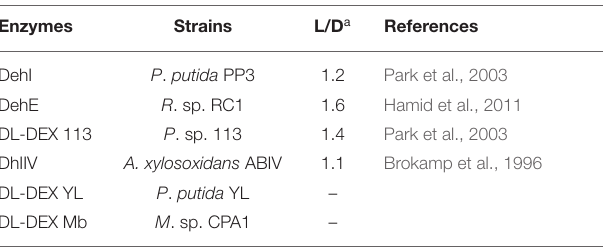
TABLE 2 | Enatioselectivity of DL-DEXis from different strains.